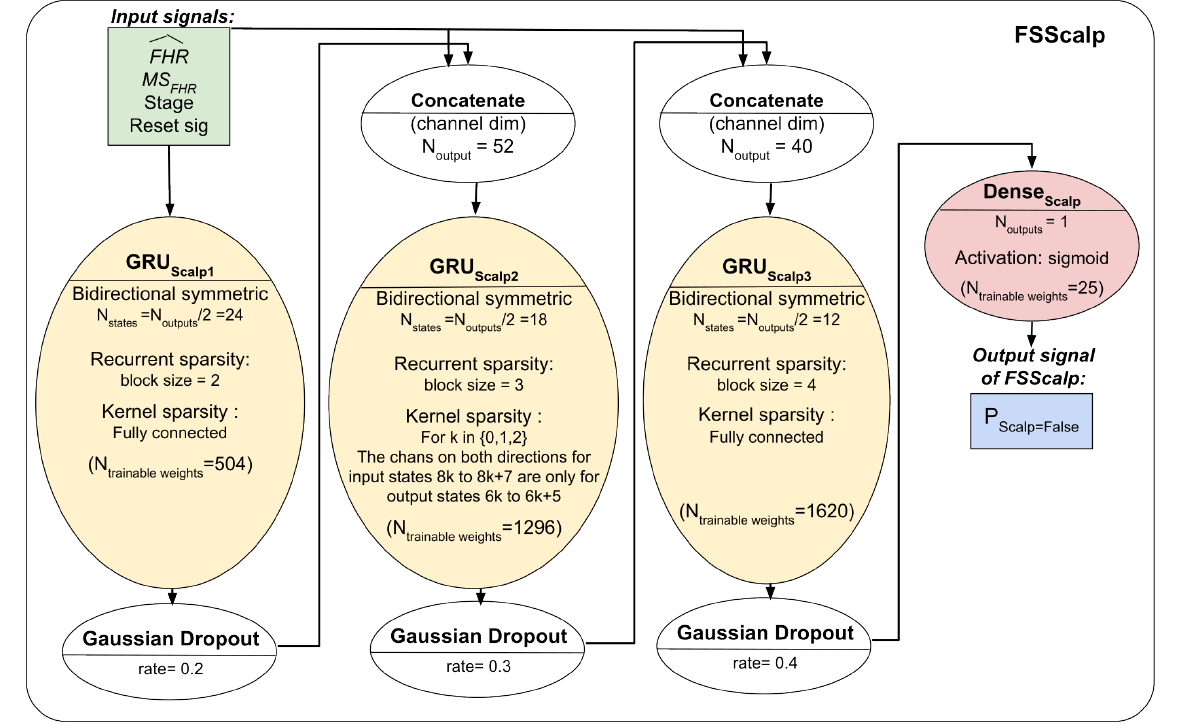
Figure 5. The FSScalp model’s architectures and hyperparameters. For each Scalp ECG FHR signal sample, FSScalp outputs the probability of being an